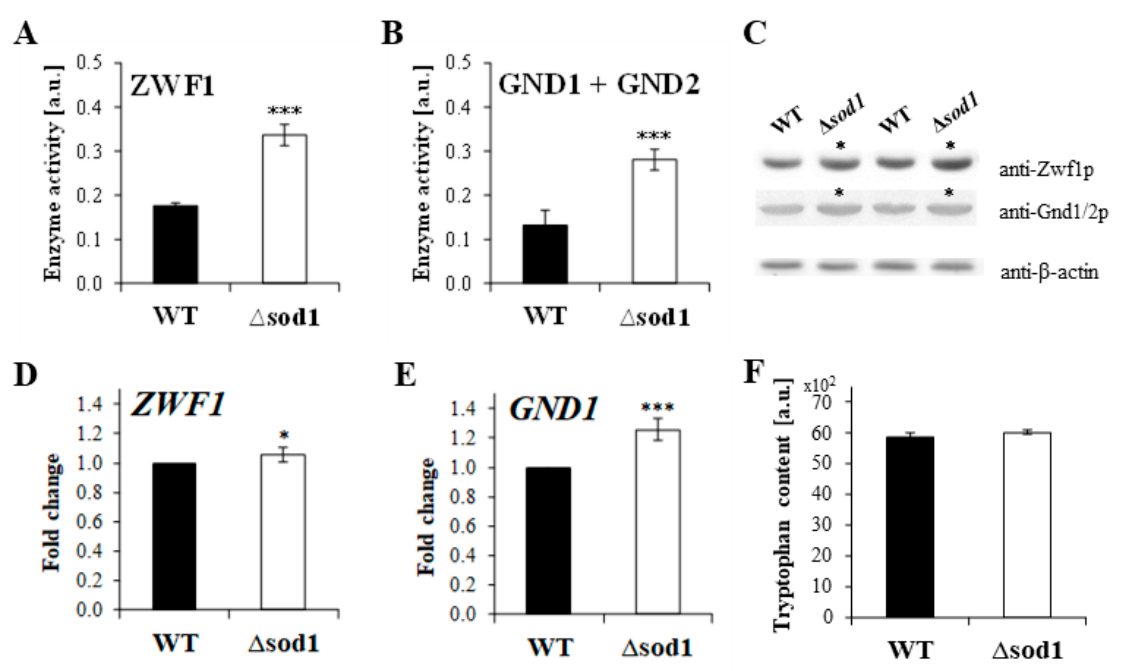
Figure 5. Activity, gene expression, and protein detection of glucose-6-phosphate dehydrogenase (ZWF1) and 6-phosphogluconate dehydrogenase (GND) in the wild-type (WT) strain and Δ sod1 mutant. The activity of glucose-6-phosphate dehydrogenase (ZWF1) was calculated by subtracting the activity of GND1 and GND2 from the total enzyme activity ( A ). The total activity of the PP pathway dehydrogenases (sum of both ZWF1 and GND1/GND2 activities) was determined with D-glucose-6-phosphate and 6-phosphogluconate as substrates and 6-phosphogluconate dehydrogenase (GND1 and GND2) activity was determined with 6-phosphogluconate, in the presence of NADP + ( B ). The ZWF1 and GND1/2 proteins were detected by immunoblotting assay with the primary antibodies: anti-glucose-6-phosphate dehydrogenase (1:2000), anti-6-phosphogluconate dehydrogenase (1:2000), and anti- β -actin (1:5000) and with the horseradish peroxidase-conjugated secondary antibodies (1:10,000 or 1:10,000) with a chemiluminescent substrate ( C ). ZWF1 ( D ) and GND1 ( E ) gene expression was performed by qPCR assay with TaqMan probes. The relative gene expression was calculated with a comparative C T method: the −ΔΔ C T method for comparison of individual gene expression between the WT and Δ sod1 mutant. The results are presented as mean ± SD from three independent experiments. * p < 0.05, *** p < 0.001 as compared to the results for the WT strain. The tryptophan content in the cell extracts was determined by fluorimetric measurements at λ ex = 290 nm and λ em = 325 nm. The results are presented as mean ± SD from three independent experiments.